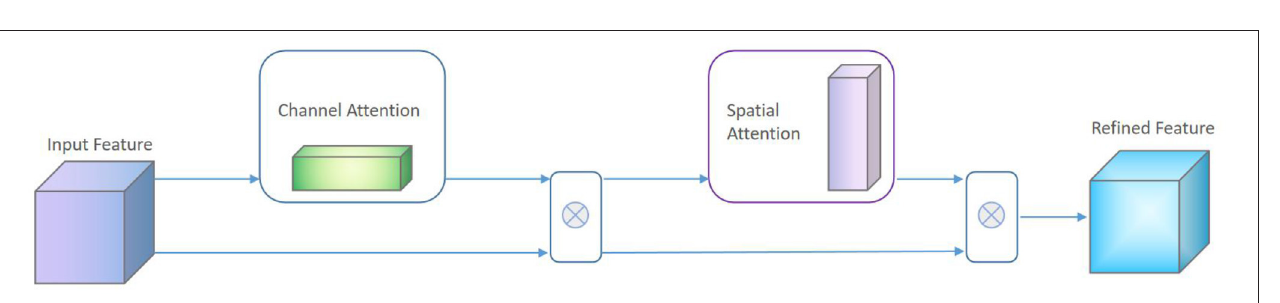
FIGURE 5 | Schematic diagram of spatial attention module.